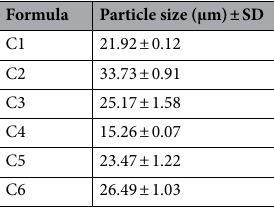
Table 4. Results of CLN-free base microsponge particle